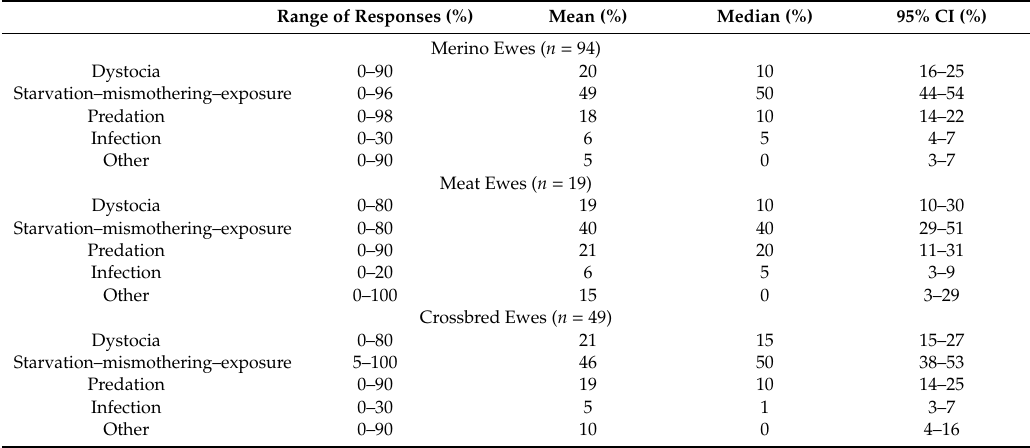
Table 6. Causes of lamb mortality and their estimated prevalence identified by 130 producers in a 2019 NSW survey to be responsible for lamb losses by ewe